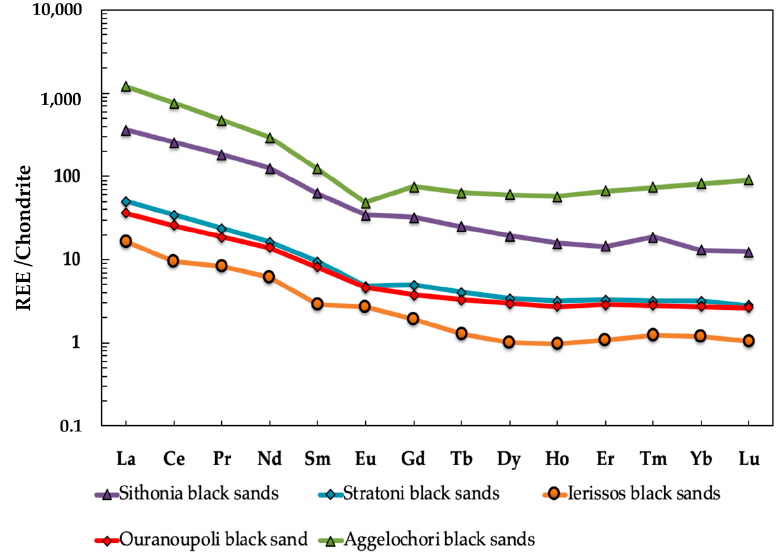
Figure 13. Chondrite-normalized diagram of REE of coastal sands derived from different regions of Chalkidiki peninsula.